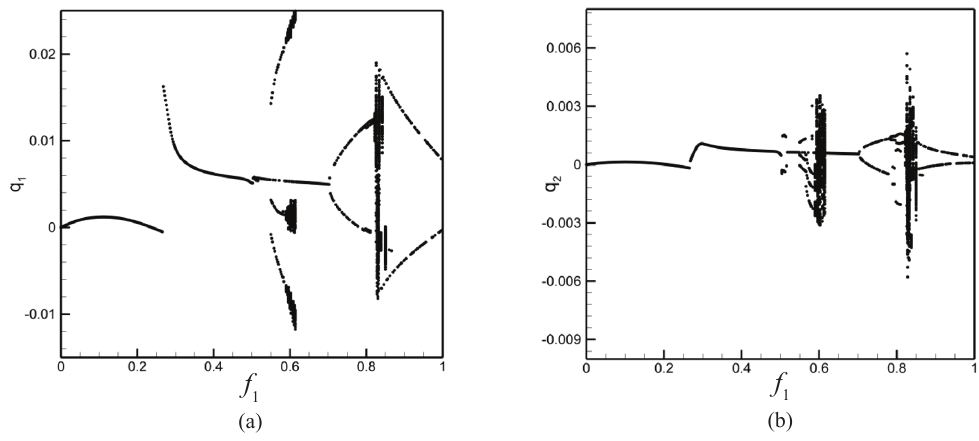
Fig. 6. Bifurcation diagrams of Poincaré points for increasing forcing amplitude on the system with c = 0 . 2 ,α = 1 . 5 and β = 0 . 3 .